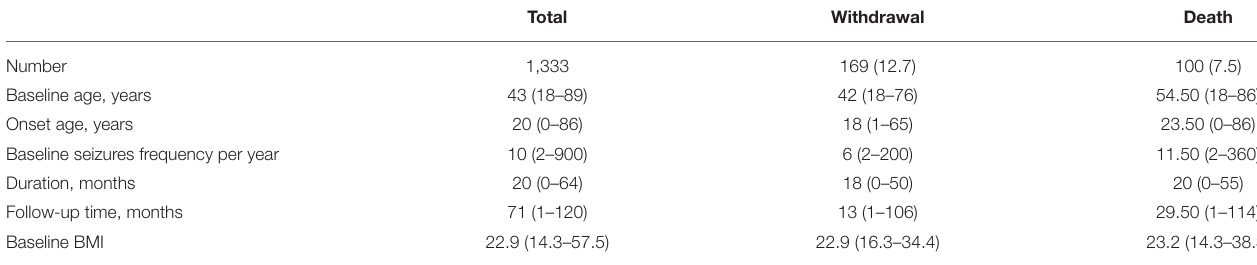
TABLE 1 | Demographic characteristics of the patients with convulsive epilepsy, N (%) or median (minimum–maximum).